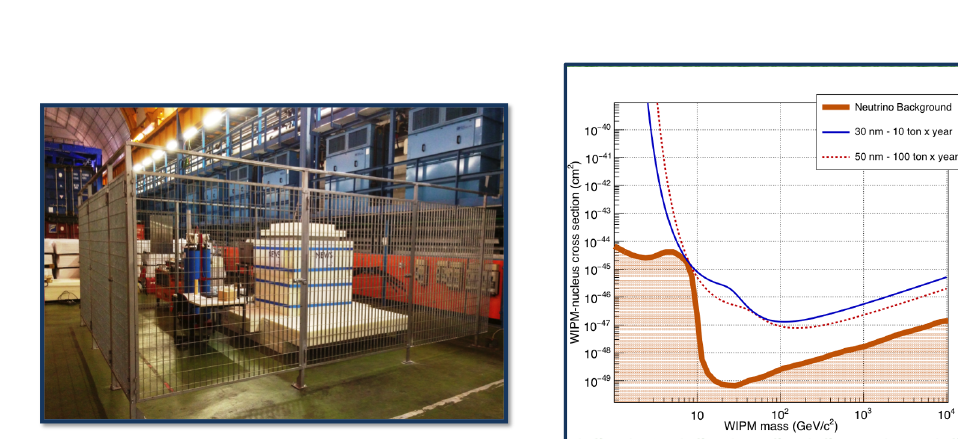
Figure 3. Picture of the shielded structure installed in the underground Hall B at Gran Sasso.